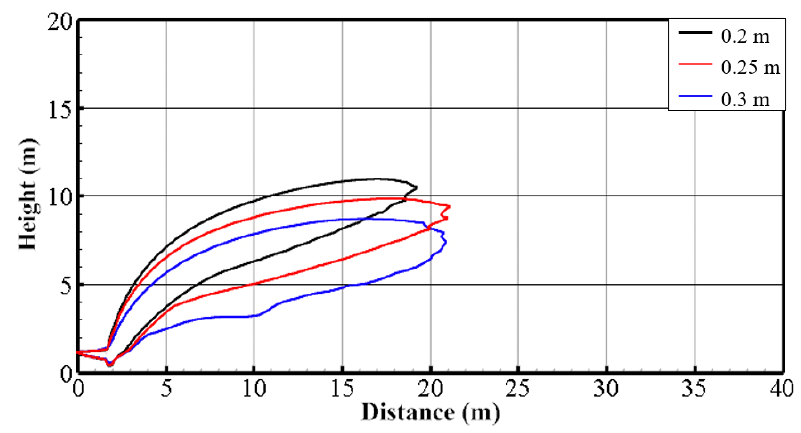
Figure 14. Contour lines in front view with various w ac values ( Q ac = 12 m 3 /s, d ac = 2 m, t = 100 s).